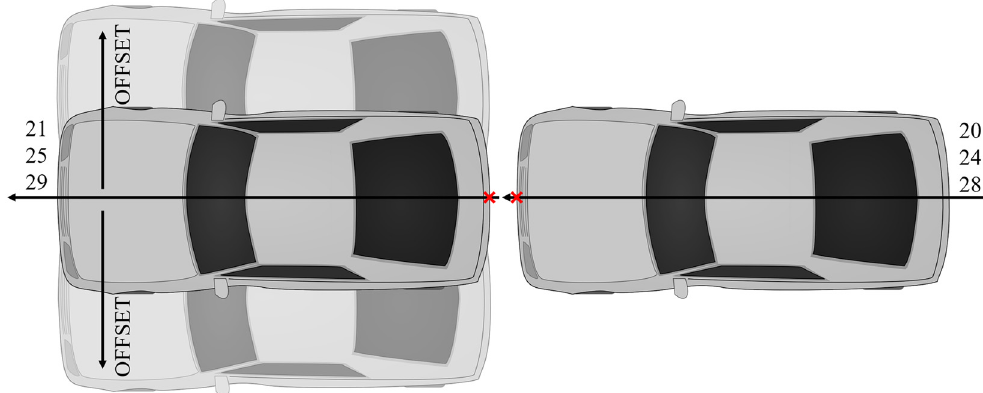
Figure A1: Collision position for scenario D – rear impacts 20, 21, 24, 25, 28, and 29.